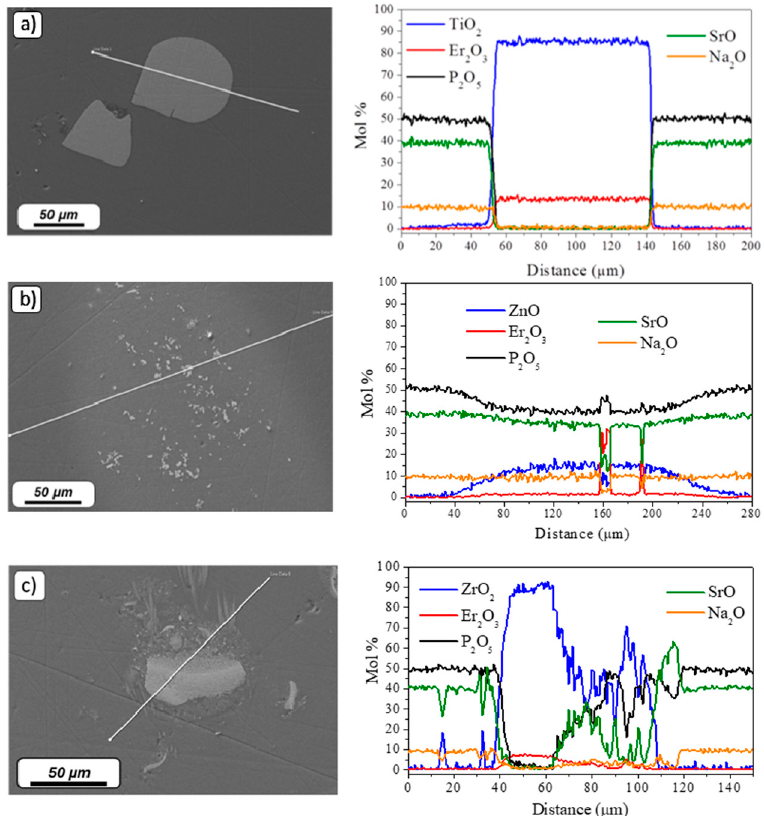
Figure 4. FE-SEM pictures with their corresponding elemental mapping of Er 2 O 3 -doped TiO 2 ( a ), ZnO ( b ), and ZrO 2 ( c ) particles-containing SrNaP glasses. The direction of the scan starts at the circle of the white line (corresponding to 0 µm).